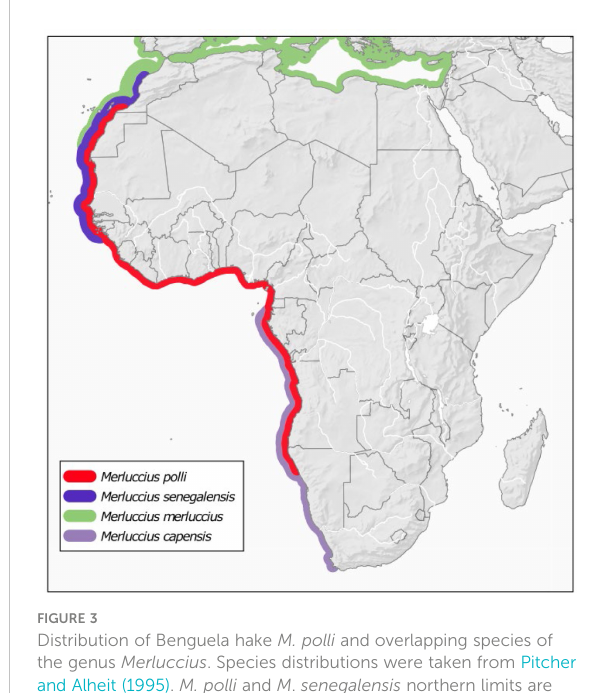
FIGURE 3 Distribution of Benguela hake M. polli and overlapping species of the genus Merluccius . Species distributions were taken from Pitcher and Alheit (1995). M. polli and M . senegalensis northern limits are updated as reported in Manchih et al.